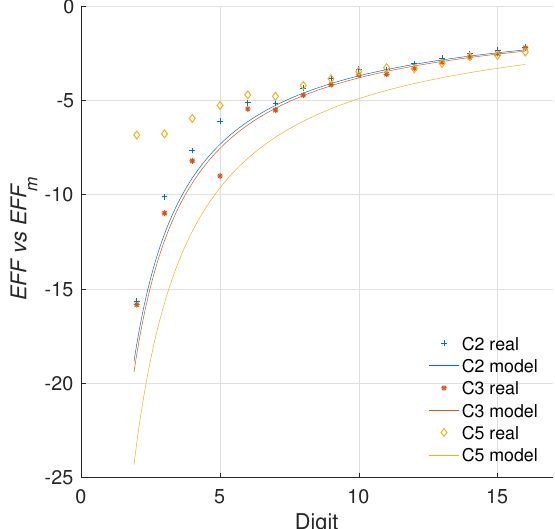
Figure 14. Evaluation of the efficiency metric for the C2, C3, and C5 configurations based on model data ( EFF m ), compared to the evaluation based on real data ( EFF